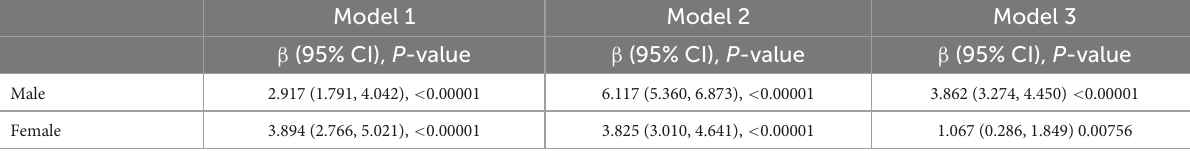
TABLE 3 Subgroup analysis stratified by gender between TyG index and 10-year risk of a first hard ASCVD